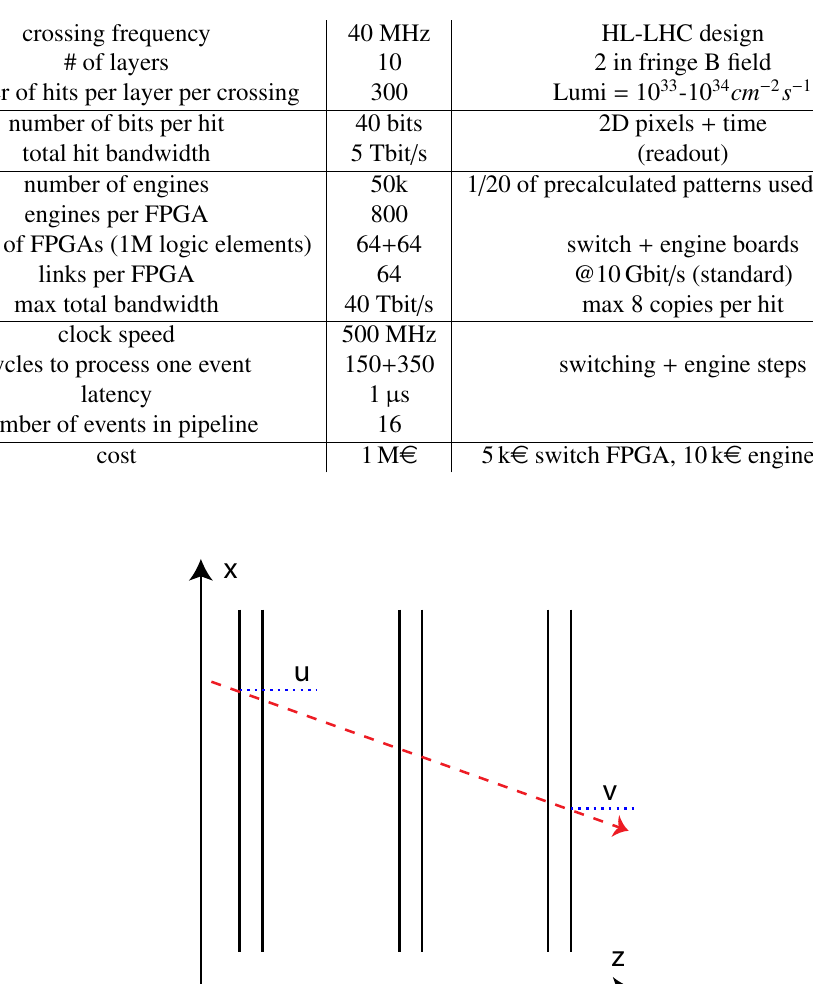
Table 1: Estimation of resources and cost for a track processing unit that can reconstruct tracks in a modern HEP detector at LHC.